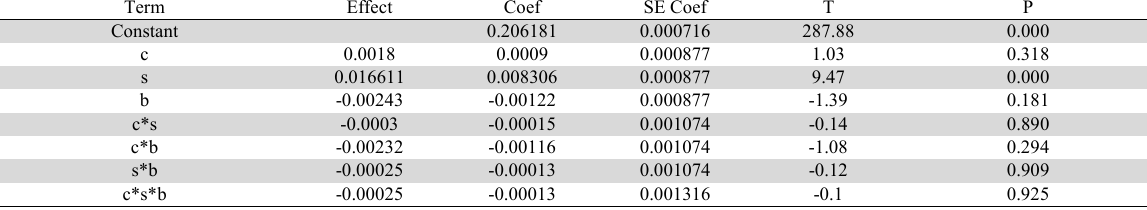
Estimated effects and coefficients for the greening cost Term Effect Coef